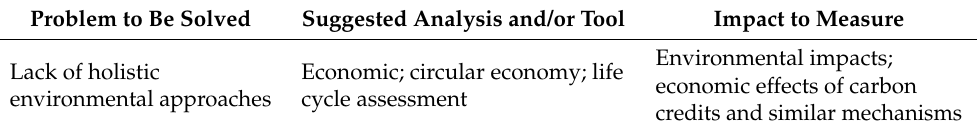
Table 12. Problems, suggestions, and impacts of environmental aspects. Source: own